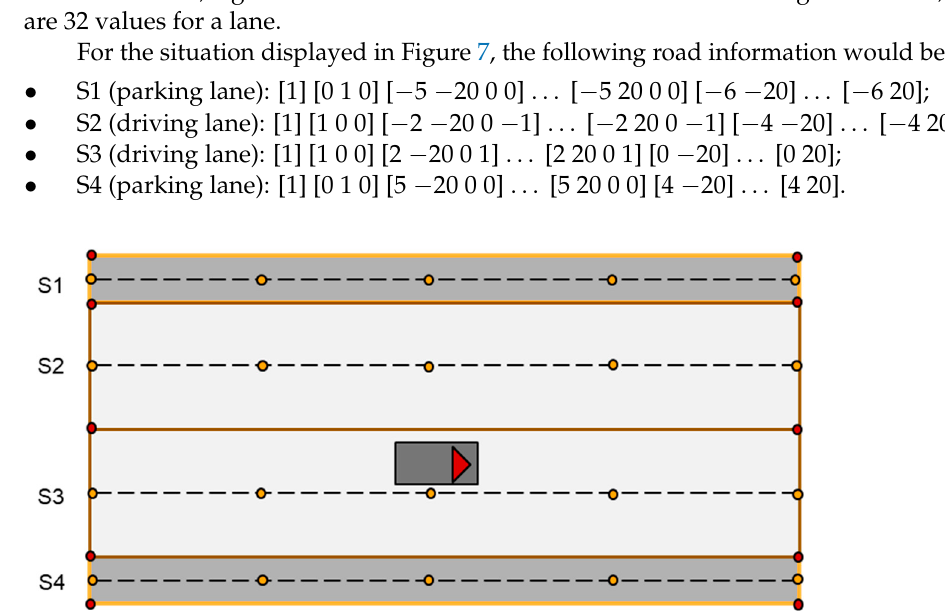
Figure 7. An example of road segment encoding.